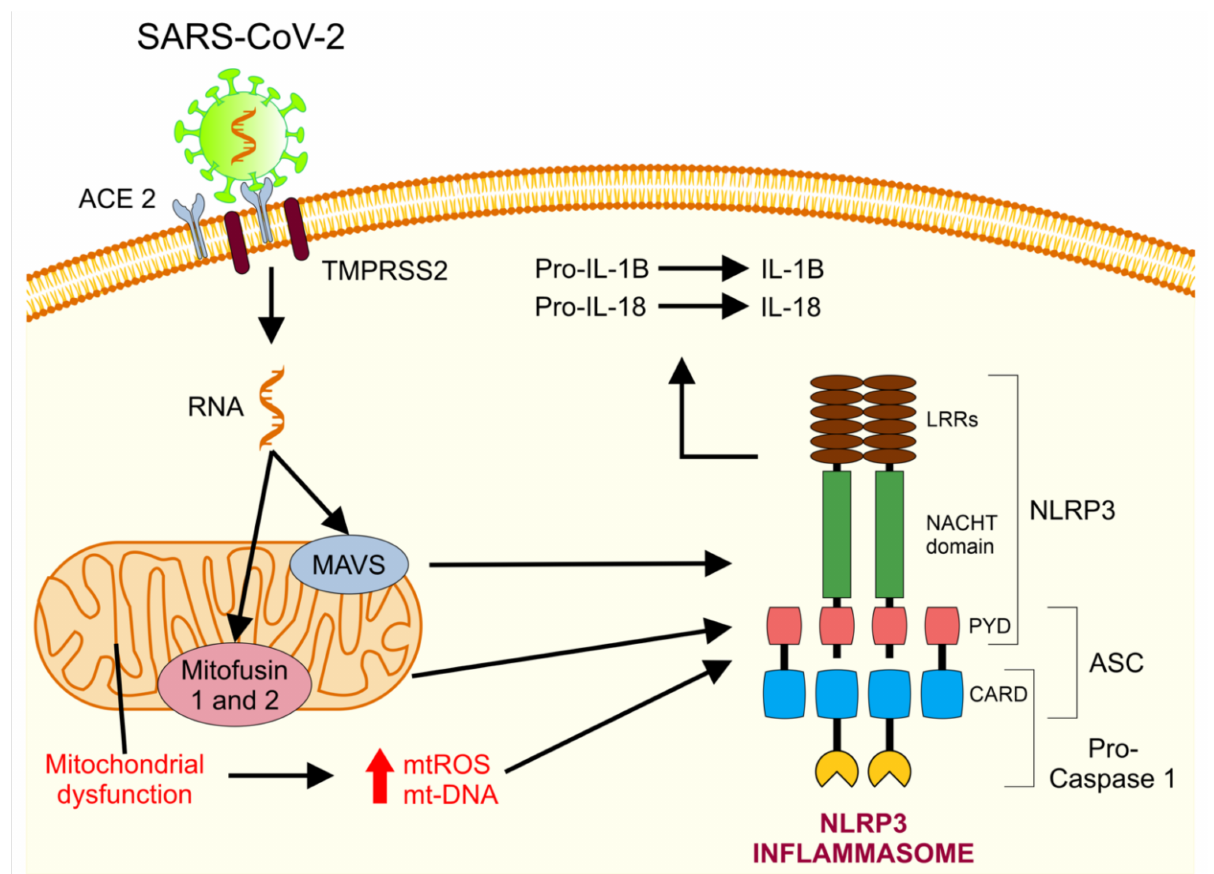
Figure 3. NLRP3 inflammasome activation by mitochondria. Once inside the cell, SARS-CoV-2 RNA is detected by the mitochondrial molecules, MAVS and mitofusin 1 and 2, causing mitochondrial dysfunction and the subsequent liberation of ROS and mt-DNA into the cytosol. This causes the activation and recruitment of NLRP3, ASC protein, and Caspase-1, which assemble to create the NLRP3 inflammasome. Once activated, the NLRP3 inflammasome cleaves the cytokines Pro-IL-1B and Pro-IL-18 into their mature and biologically active forms (IL-1B and IL-18), thus exacerbating the inflammation state [78]. ASC: apoptosis-associated speck-like protein containing a CARD. CARD: caspase recruitment domain. LRR: leucine-rich repeats. PYD: pyrin